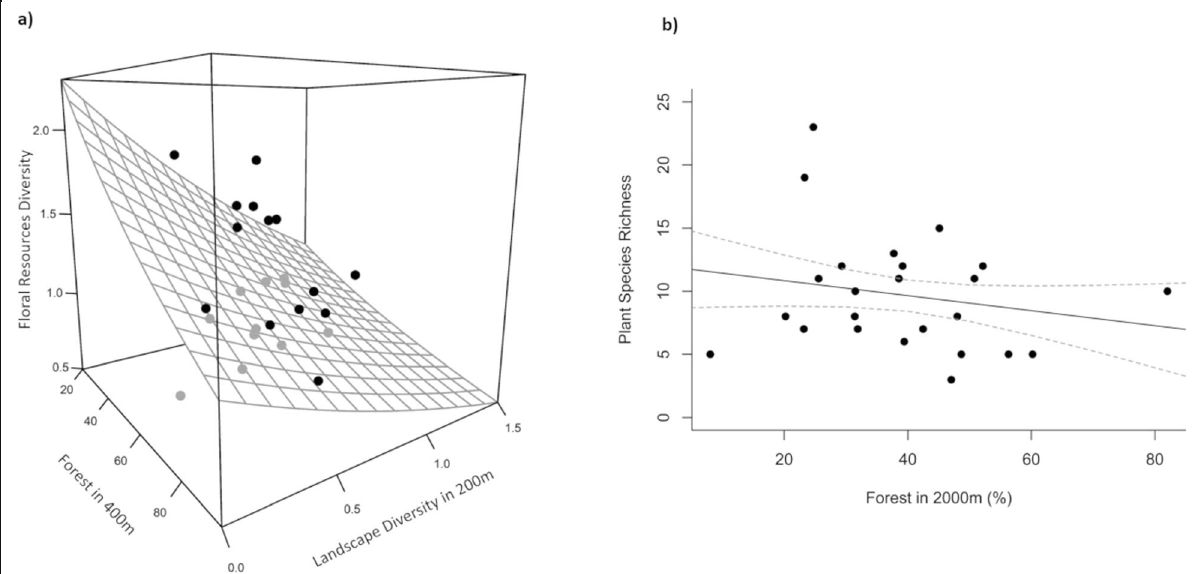
Fig. 2 a Effects of forest cover (%) at a 400-m scale and landscape heterogeneity ( H ’ ) at a 200-m scale on floral resource functional diversity ( H ’ ); black dots represent values above the surface and gray dots below. b Effects of forest cover (%) at a 2000-m scale on species richness. Black dots are the residuals, and lines are the predicted values based on generalized linear models. Dashed lines represent confidence intervals (R Core Team,